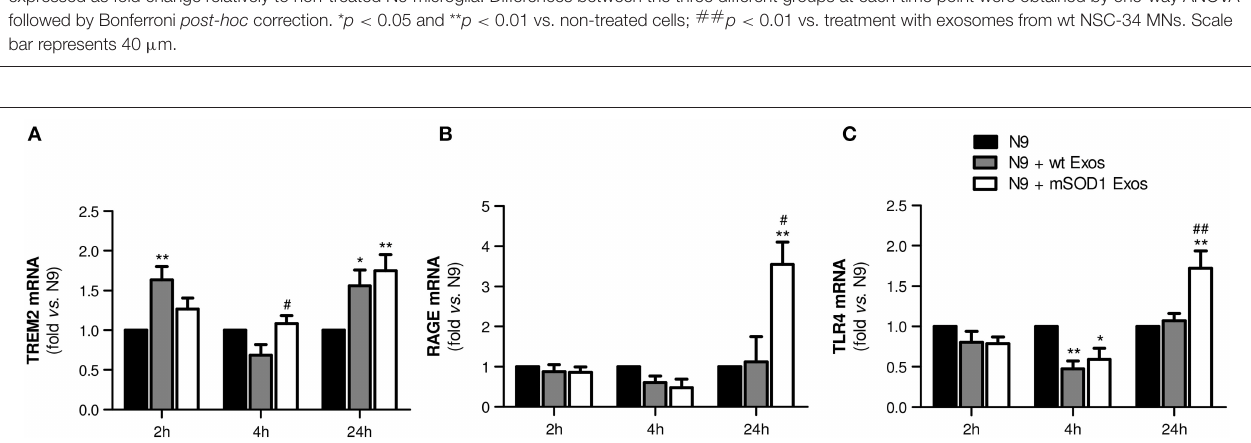
FIGURE 5 | Exosomes from NSC-34 motor neurons (MNs) mutated in G93A (mSOD1) lead to delayed upregulation of the receptors TREM2, RAGE and TLR4 in N9 microglia. N9 cells were incubated for 2, 4, and 24 h with exosomes (Exos) from wild-type (wt) NSC-34 MNs and mSOD1 NSC-34 MNs (N9 + wt Exos and N9 + mSOD1 Exos, respectively), as indicated in methods. Non-treated cells were considered as control. Gene expression of (A) triggering receptor expressed on myeloid cells 2 (TREM2), (B) Receptor for Advanced Glycation Endproducts (RAGE) and (C) Toll-like receptor-4 (TLR4) was determined by qRT-PCR in total RNA. Results are mean ( ± SEM) from at least five independent experiments and are expressed as fold change relatively to non-treated N9 microglia. Differences between the three different groups at each time point were obtained by one-way ANOVA followed by Bonferroni post-hoc correction. * p < 0.05 and ** p < 0.01 vs. non-treated cells; # p < 0.05 and ## p < 0.01 vs. treatment with exosomes from wt NSC-34 MNs.